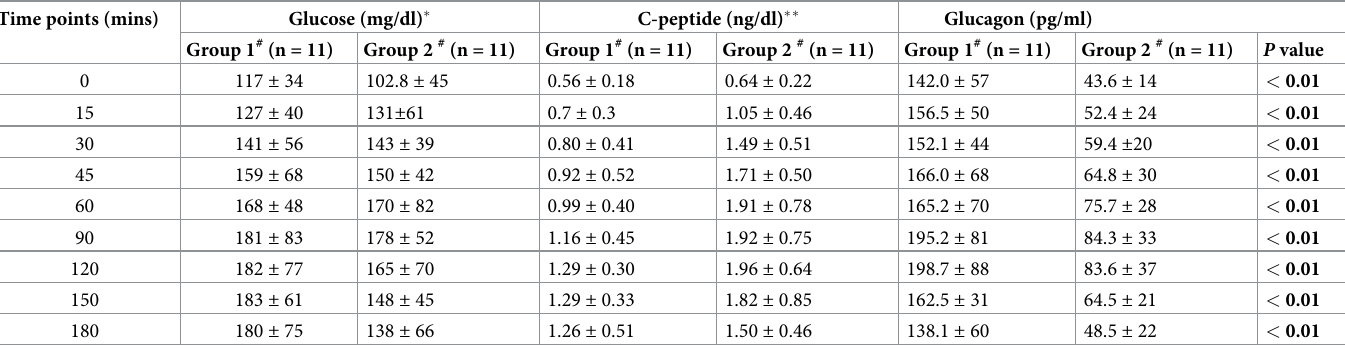
Table 3. Glucose, C-peptide and glucagon levels in response to MMCT in patients with FCPD and hypoglycemia awareness / unawareness. Time points (mins)